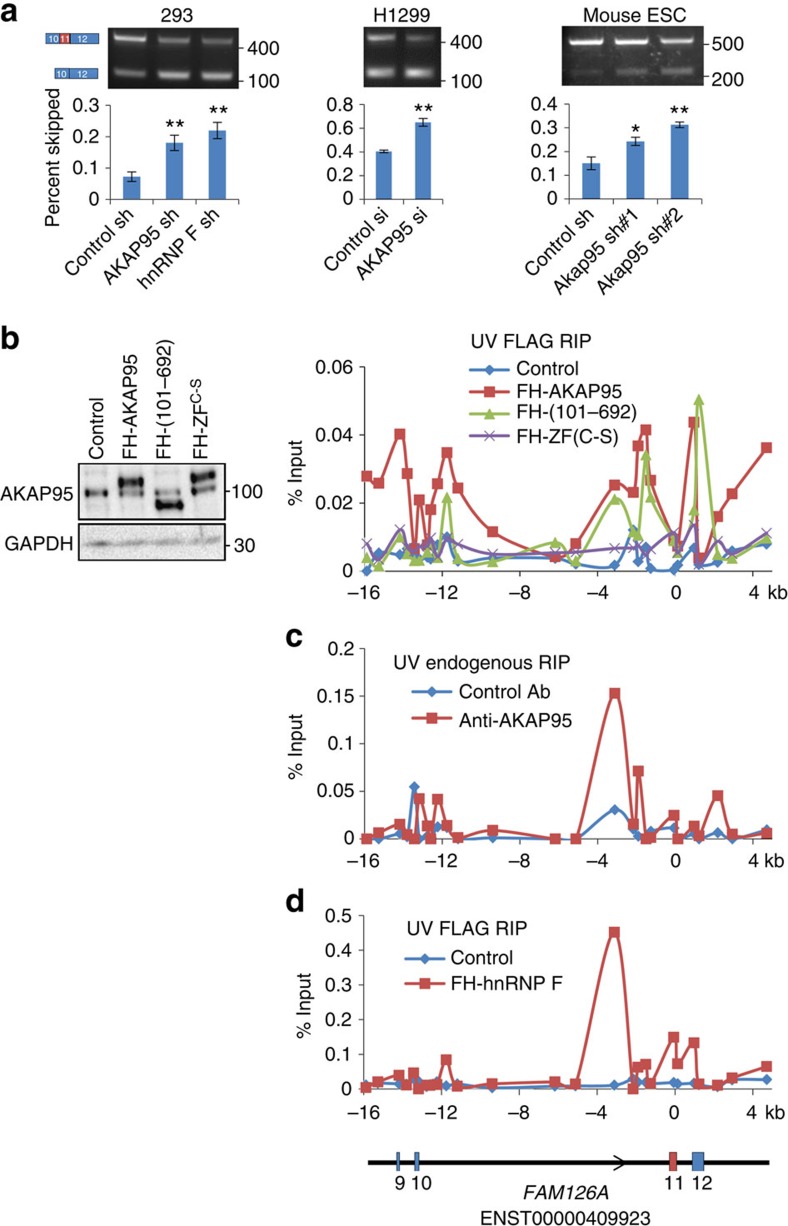
AKAP95 directly regulates AS of FAM126A.(a) PCR assays for skipping of FAM126A exon 11 following AKAP95 KD in human 293 and H1299 cells and also in mouse ES cells using indicated shRNAs (for 293 and ES cells) or siRNAs (for H1299). Scramble shRNA was used as control shRNA, and GL2 siRNA targeting luciferase RNA was used as control siRNA. Following quantification of band intensities by the ImageJ programme, the percentage of the PCR product representing exon 11-skipped transcript in the total transcripts was calculated and shown as ‘percent skipped' on the y axis. For all cells, average±s.d. from three biological repeats are plotted. *P<0.01, **P<0.001 between the indicated sample and their corresponding control sample. (b) Expression of FH-AKAP95 or the indicated mutants was induced by doxycycline in stable Flp-In T-REx 293 cell lines. The control is the parental Flp-In T-REx 293 cells. The expression levels were shown by western blotting for AKAP95 (left). Anti-FLAG RIP assays were performed in these cell lines after ultraviolet-crosslinking, and followed by qPCR assays with a series of primers (represented by dots on the curves) at the FAM126A locus (diagram at the very bottom of this figure). Another biological repeat of RIP assay is shown in Supplementary Fig. 3d. (c) RIP assays using control (normal rabbit IgG) or anti-AKAP95 antibody were performed in 293 cells after ultraviolet-crosslinking, and followed by qPCR by the same series of primers as in b at the FAM126A locus. Two more independent biological repeats are shown in Supplementary Fig. 3e. (d) 293T cells were transfected with empty vector (control) or the FH-hnRNP F plasmid to express sub-endogenous level of FH-hnRNP F using a plasmid dose equivalent to that circled in Supplementary Fig. 3g. Anti-FLAG RIP assays were performed after ultraviolet-crosslinking, and followed by qPCR at FAM126A. Two more independent biological repeats are shown in Supplementary Fig. 3f.